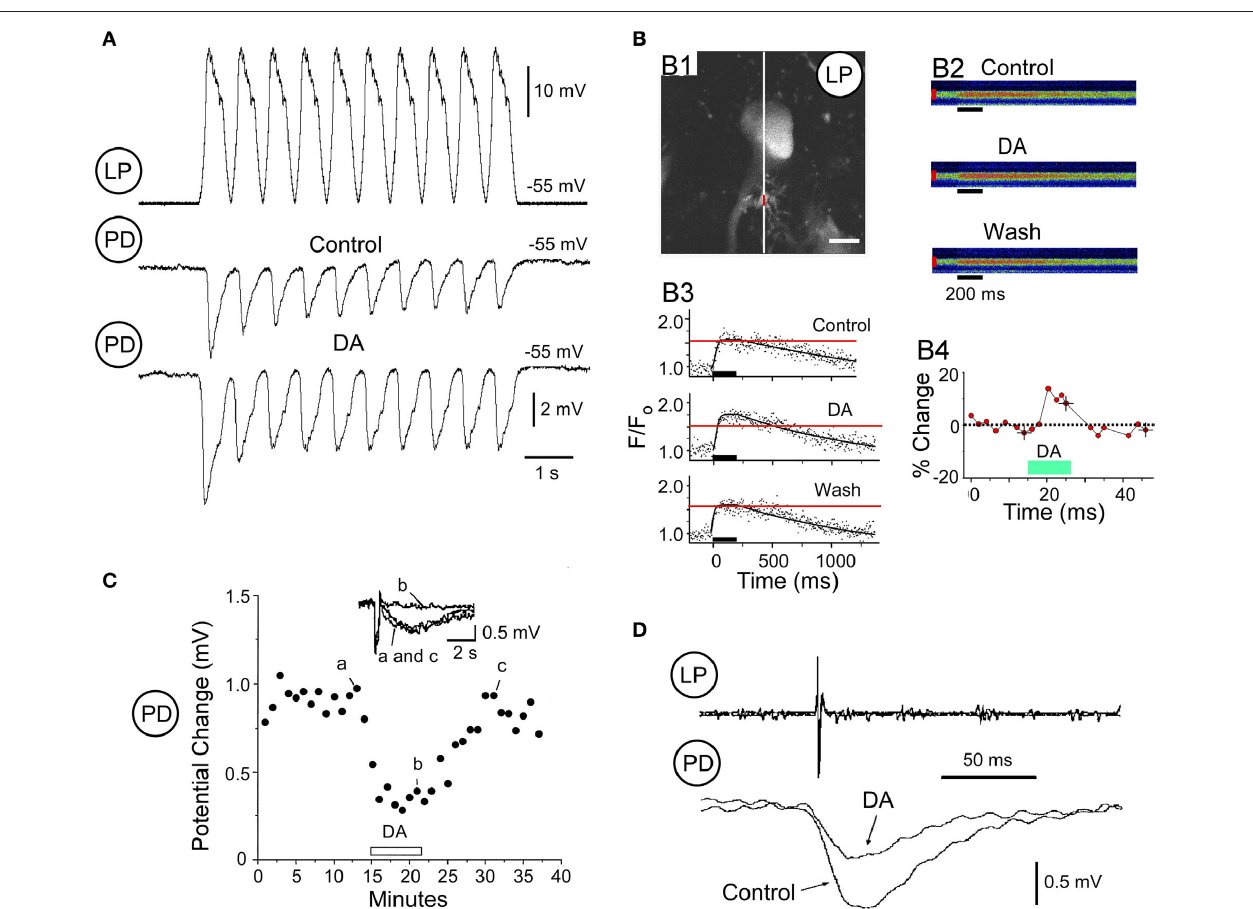
increase in fluorescence over baseline level. B3: Line scans before, during, and after bath application of DA. Ca 2 + accumulation was induced by a 200-ms voltage pulse from − 45 to 0 mV (black bars). B4: quantified changes in fluorescence extracted from the line scans in B3. (C) DA reduces the PD response to iontophoresis of the LP’s transmitter glutamate (Glu). Peak voltage response to Glu is measured every 60 s before DA (a), during DA (b; bar above the x -axis), and during a wash period (c; modified from Johnson and Harris-Warrick, 1997). (D) DA reduces the LP IPSP evoked by an LP action potential, recorded extracellularly on the lateral ventricular nerve (top trace) (modified from Ayali et al.,